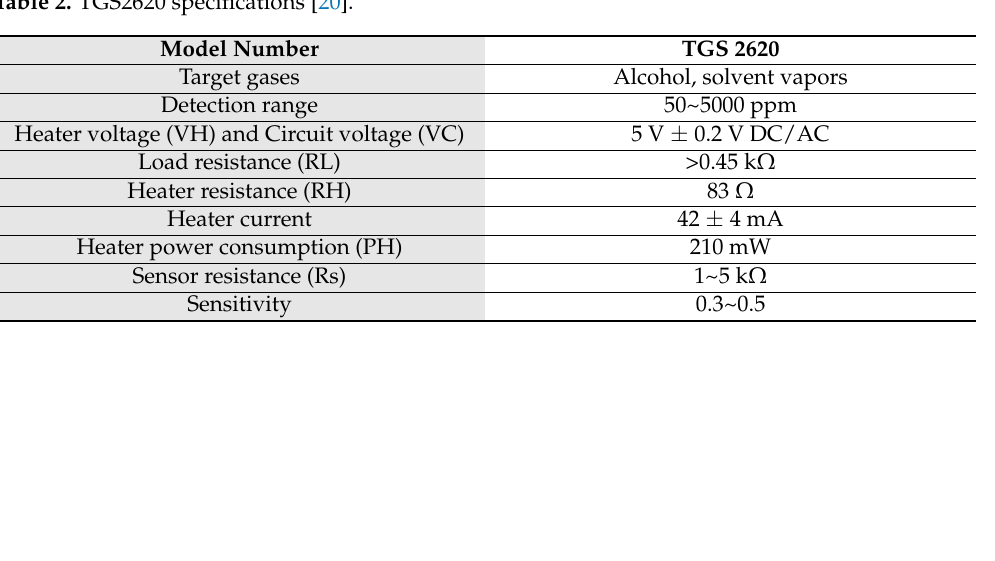
Table 2. TGS2620 specifications